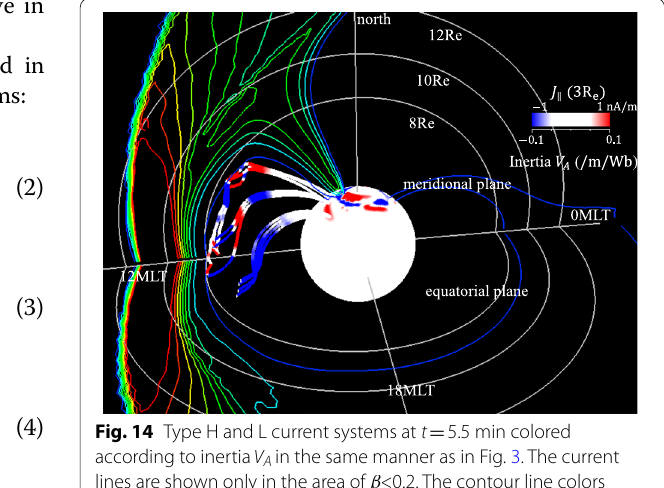
5.5 min colored =